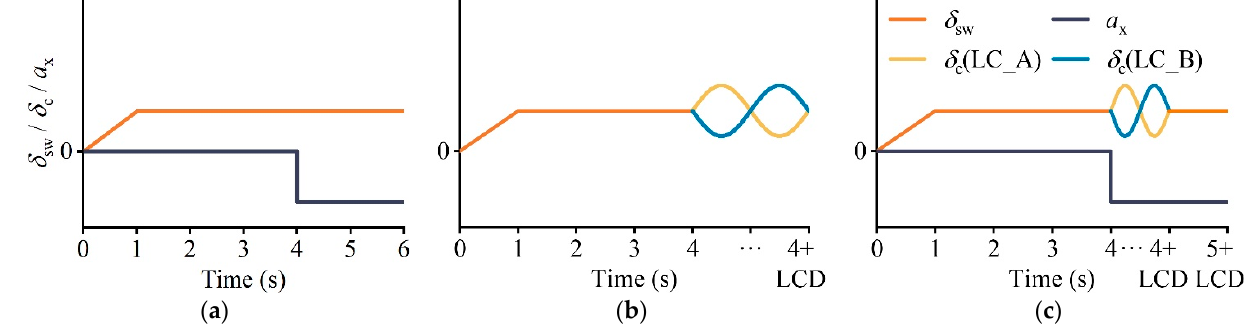
Figure 5. Input time point of the steering wheel angle and deceleration. ( a ) Pure braking manipulation. ( b ) Pure lane change manipulation. ( c ) Lane change with braking